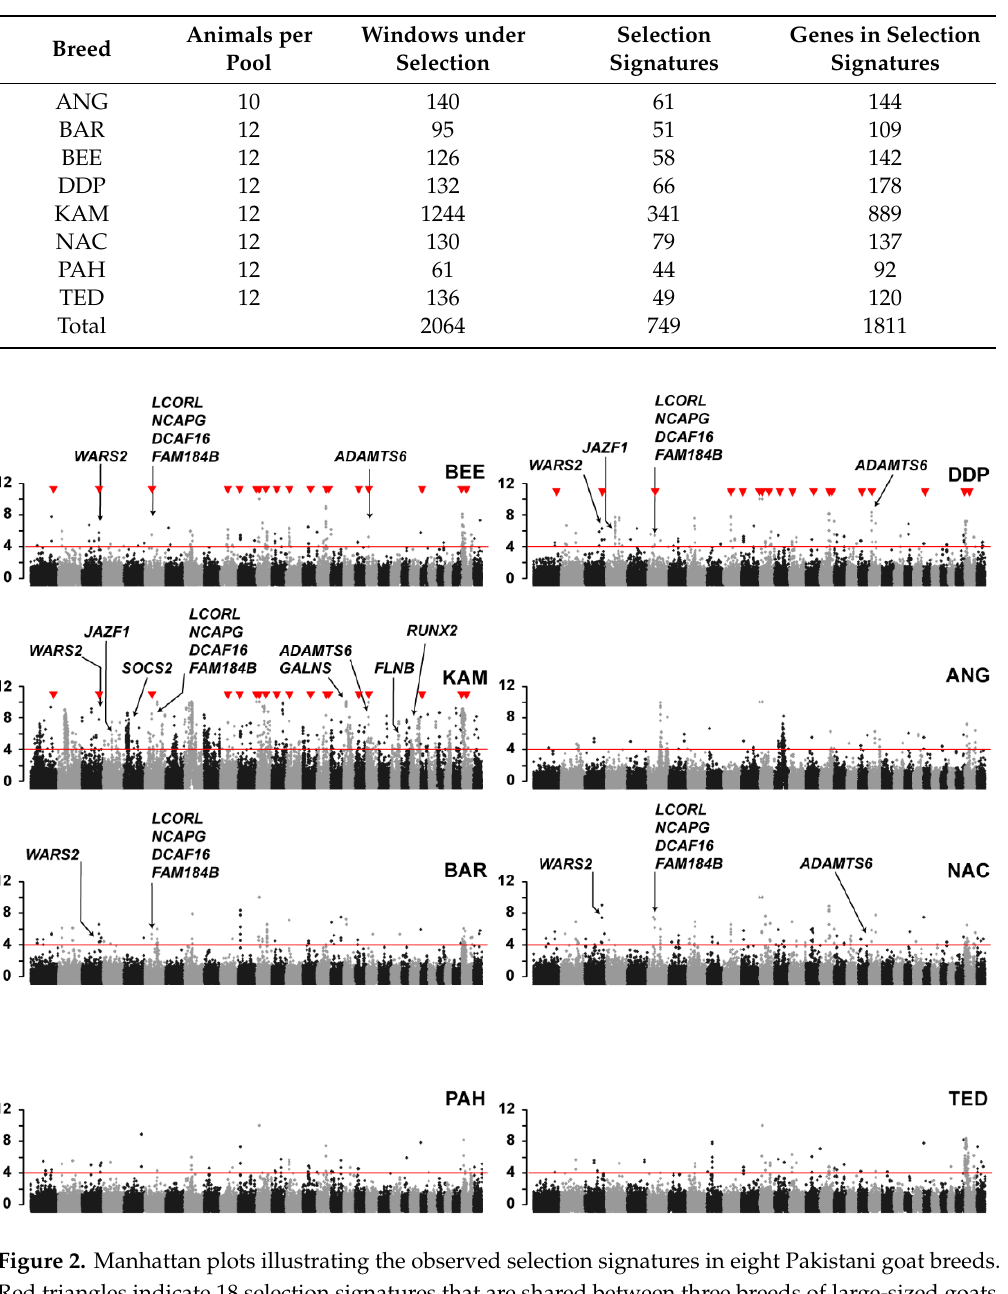
Table 3. Selection signatures in the Pakistani goat breeds.